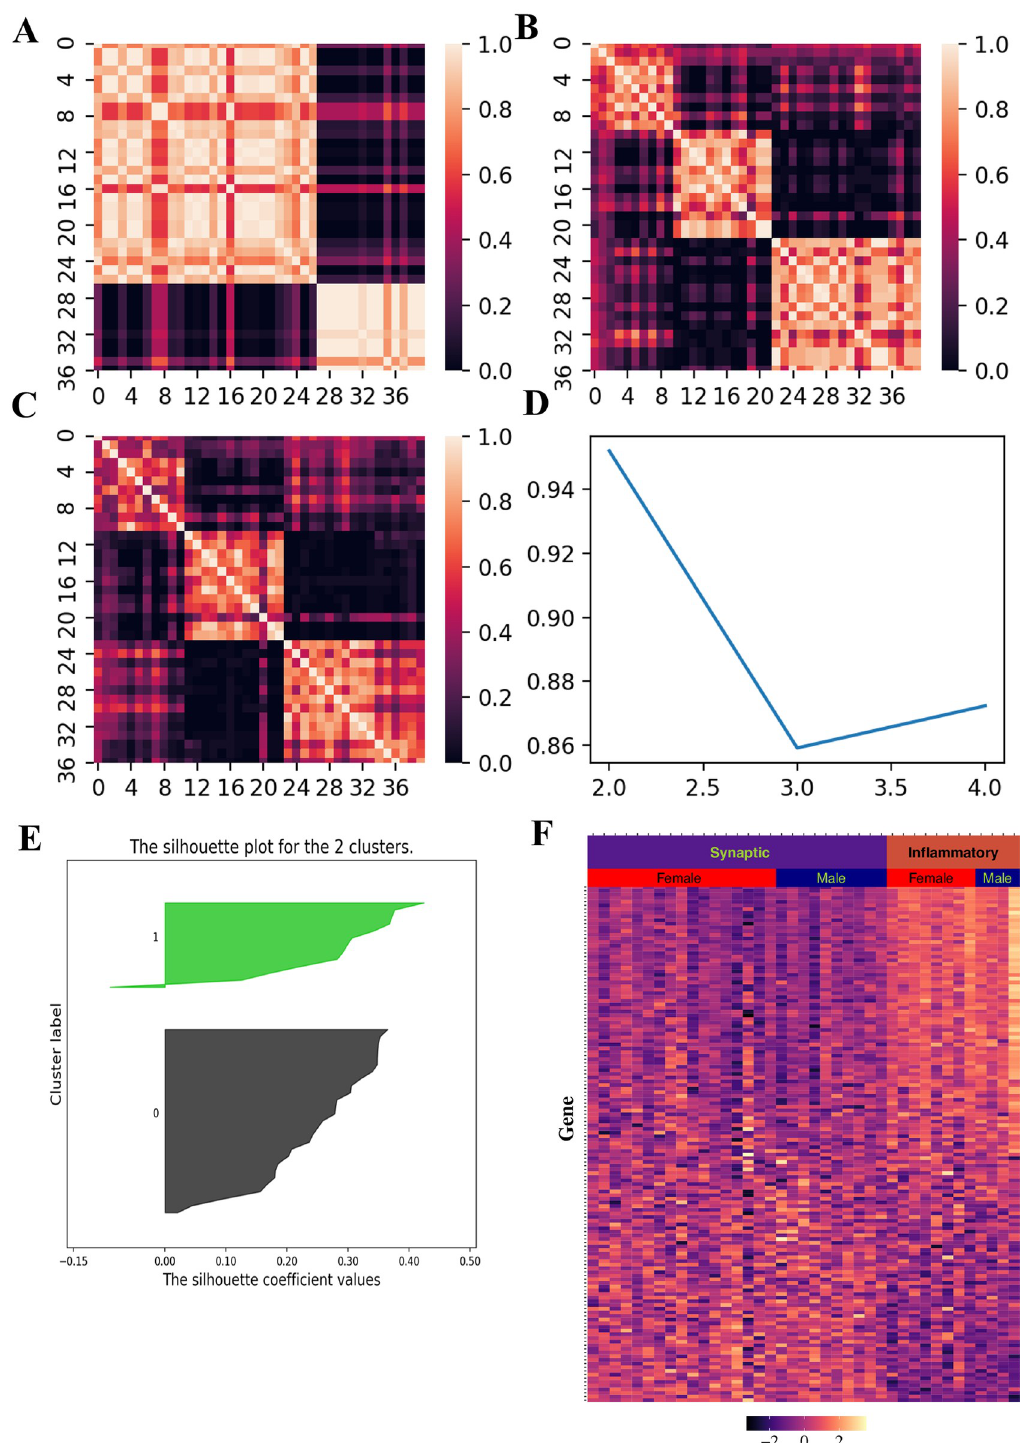
Fig 6. Molecular subtype validation in GEO dataset (GSE118553). (A-C) Consensus matrices for 2, 3 and 4 clusters respectively. (D) Plot of cophenetic correlation coefficient against the number of clusters. (E) Silhouette distance for each sample. (F) Heatmap for signature gene